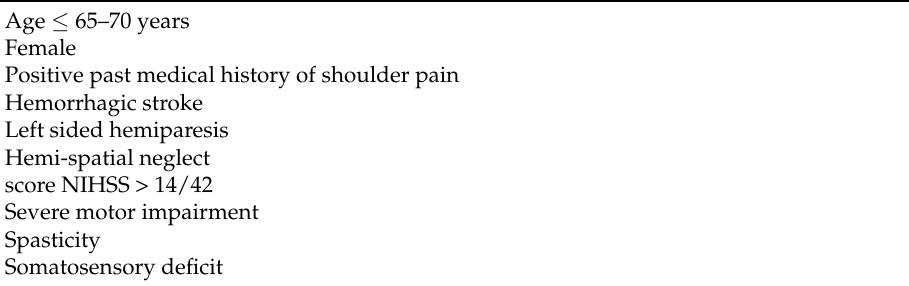
Table 1. Predictors for the development of hemiplegic shoulder